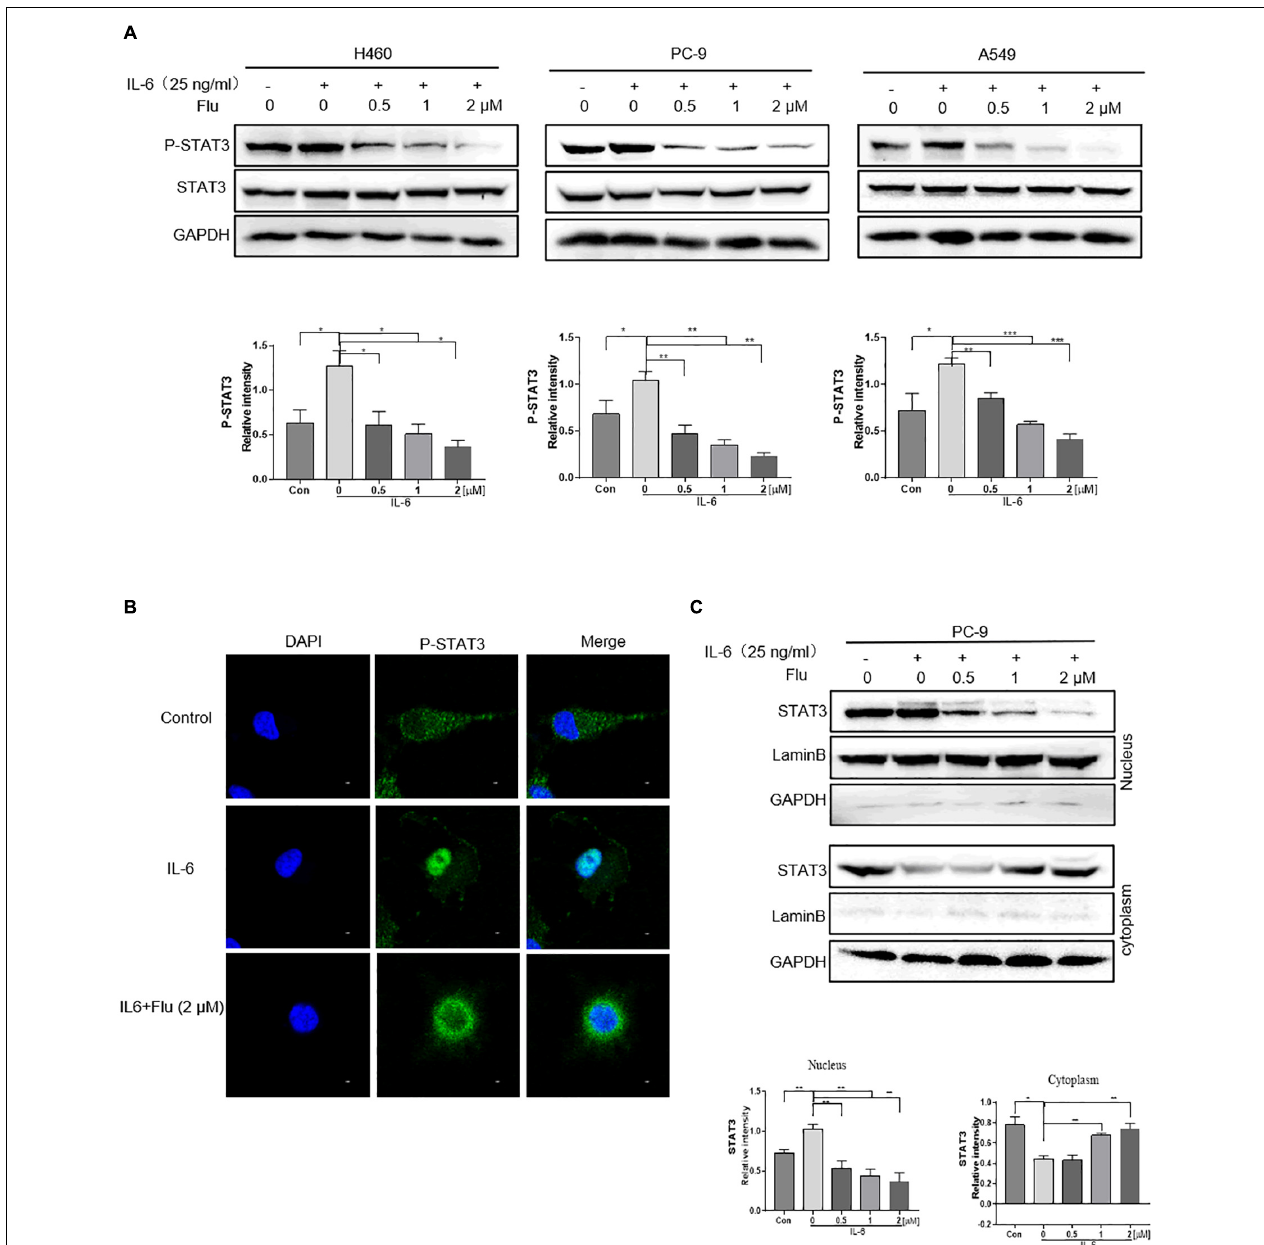
FIGURE 4 | Flubendazole inhibited nuclear translocation of STAT3. (A) Expression of STAT3 in the cytosol and in the nucleus confirmed by western blotting assays. (B) Representative confocal microscopic images indicating the localization of p-STAT3 (green) and DAPI in PC-9 cells. (C) The expression levels of STAT3 in nuclear and cytosolic fractions were determined by using the western blot analysis. Images shown are representative of three separate experiments (* P < 0.05, ** P < 0.01, *** P <